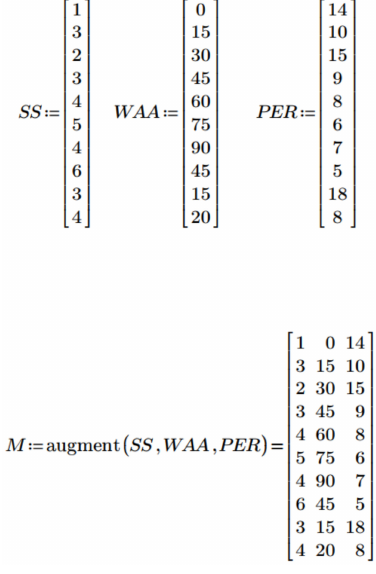
Figure 14. Matrix